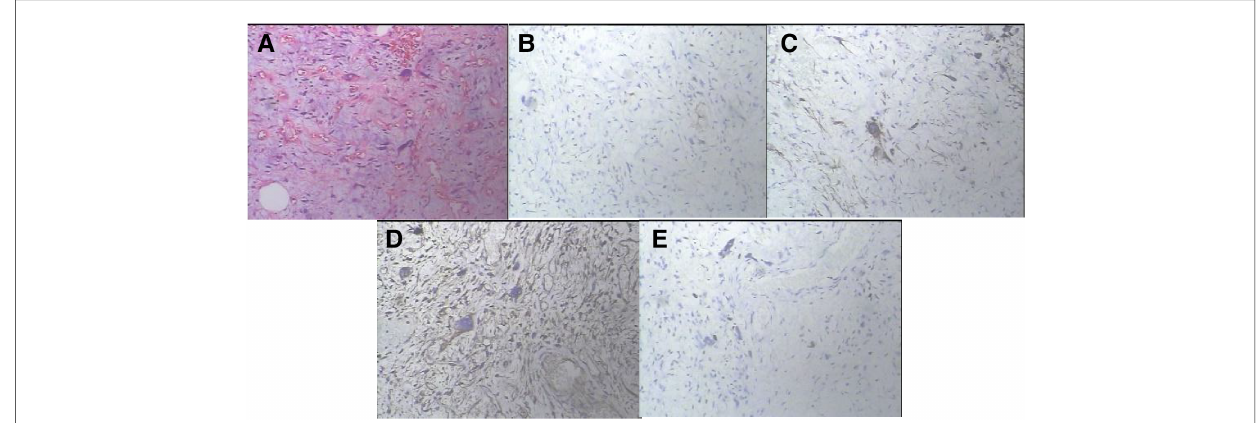
FIGURE 4 The histopathological fi ndings and immunostaining. Postoperative routine pathology showed that left inguinal scrotal liposarcoma was primarily WDLPS, some of which were MLPS (about 20%), with a tumor size of 26 cm×17 cm×13 cm, accompanied by chronic in fl ammation of three lymph nodes around the tumor, and spindle cell malignant tumor of left femoral vein lymph nodes, which was considered as liposarcoma ( A ). On immunostaining, the tumor cells were focally positive for S-100 ( B ), Des ( C ), Vim ( D ) and Ki-67(5%) ( E ) and negative for CD34, Actin, CK, SMA, catenin- β and STAT6. ( A ×100 magnifcation, B – E ×200